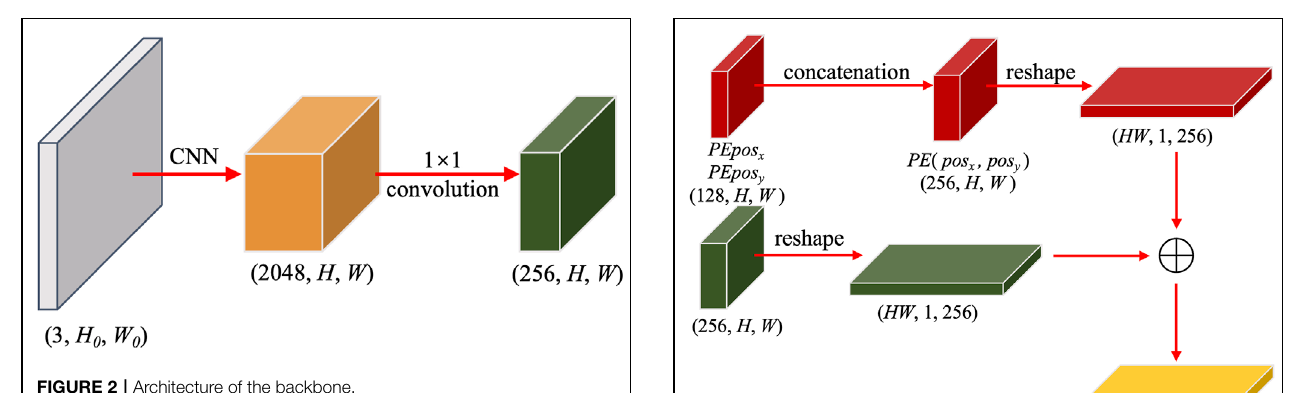
FIGURE 2 | Architecture of the backbone.